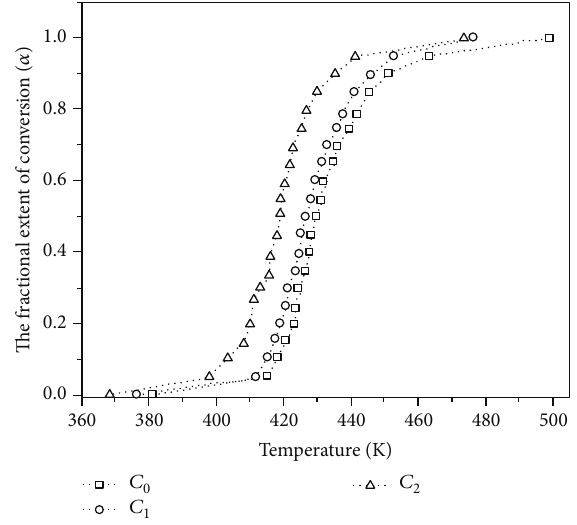
Figure 7: DSC thermograms at 20 ∘ C/min of neat epoxy ( 𝐶 0 ), 0.5 wt% as-received MWCNTs/epoxy nanocomposites ( 𝐶 1 ), and 0.5 wt% amine-modified MWCNTs/epoxy nanocomposites ( 𝐶 2 ). Dotted lines are given for showing the tendency. After